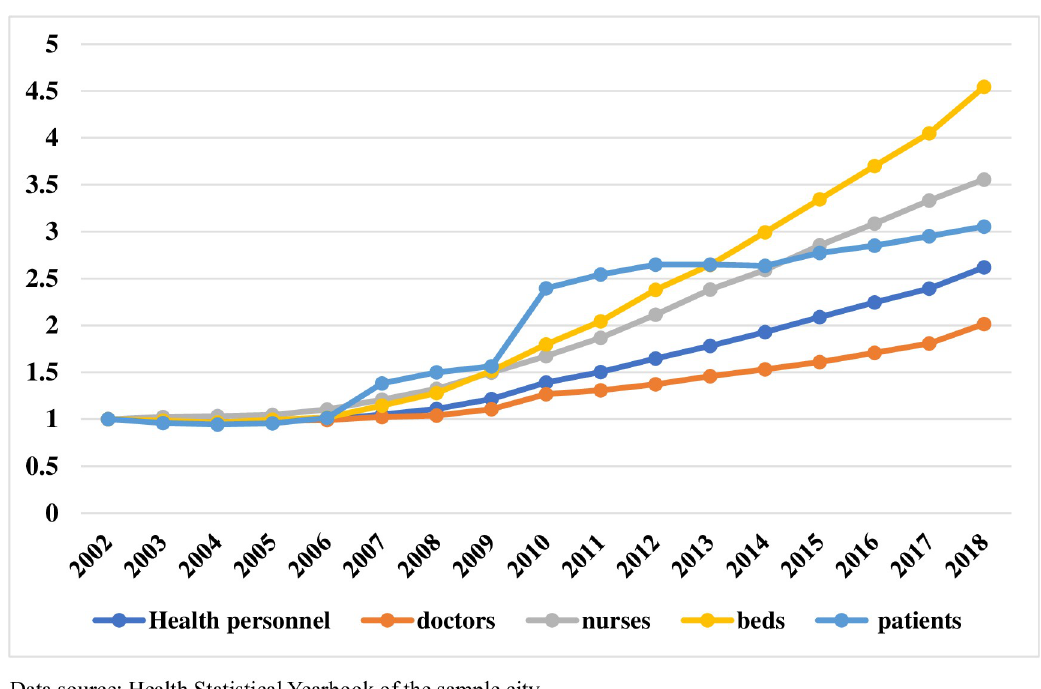
Fig 2. Health personnel, beds, and patient statistics in city investigated from 2002 to 2018. Y-axis represents annual growth rates.